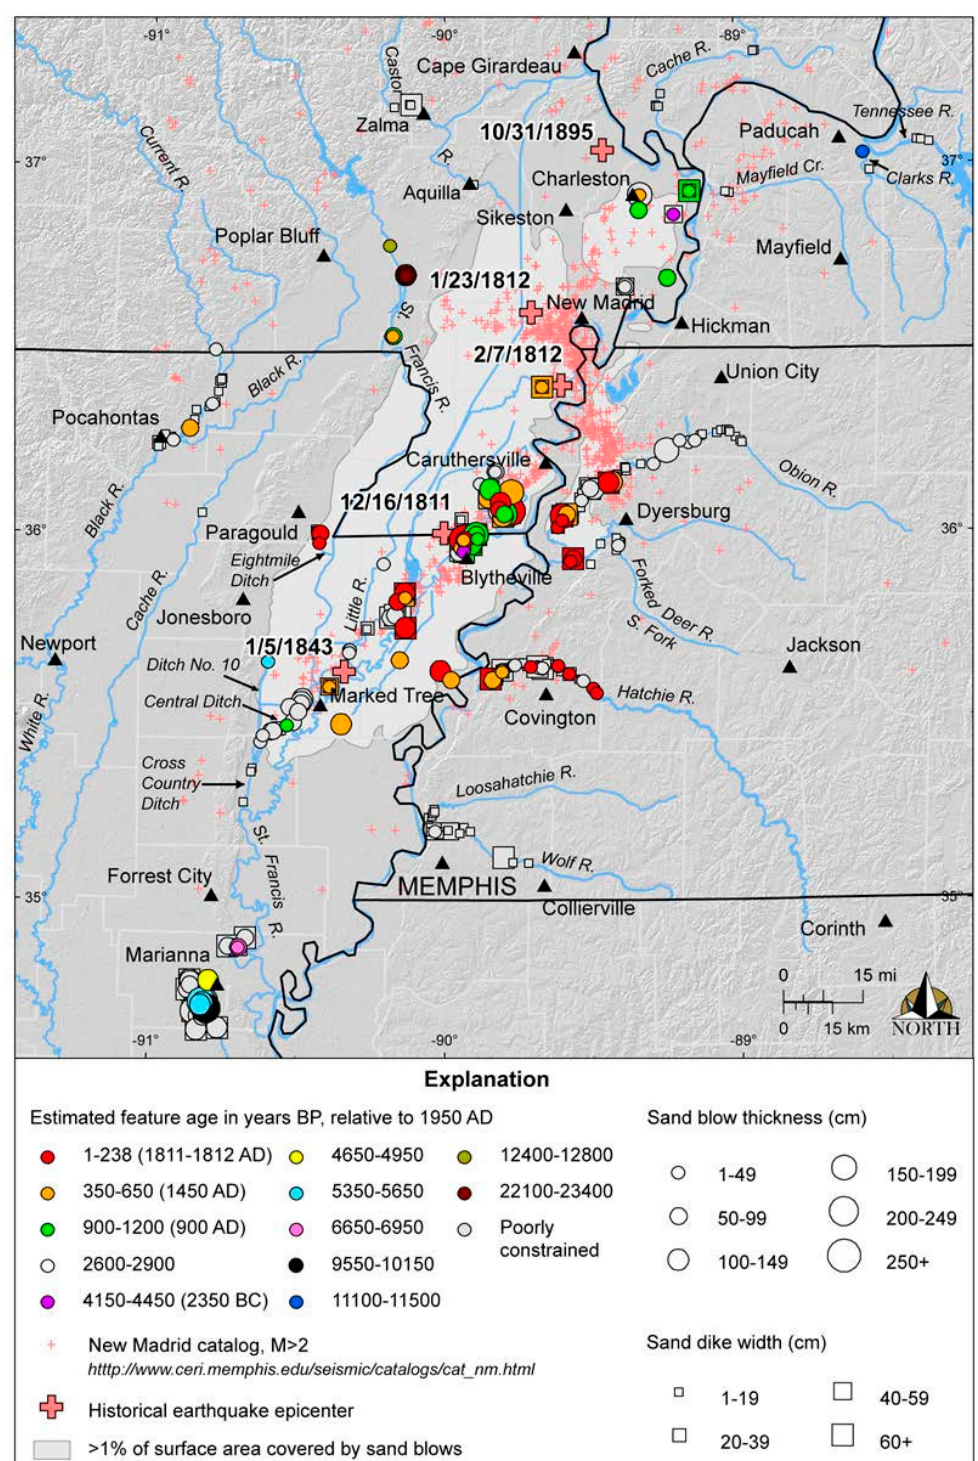
Figure 17. Shaded relief map of New Madrid seismic zone (NMSZ) and surrounding region showing ages and measured sizes of earthquake-induced liquefaction features, previously recognized liquefaction field, inferred locations of historical earthquakes, and instrumental located earthquakes [148].